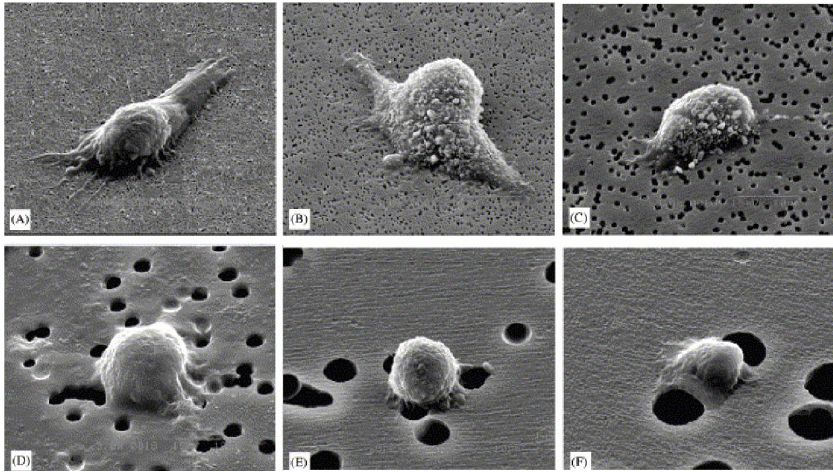
Figure 3. SEM images of adhesion of MG63 cells to the PC membrane surfaces with different surface roughnesses: ( A ) 0.2, ( B ) 0.4, ( C ) 1.0, ( D ) 3.0, ( E ) 5.0, and ( F ) 8.0 mm [78]. © Elsevier, 2004.